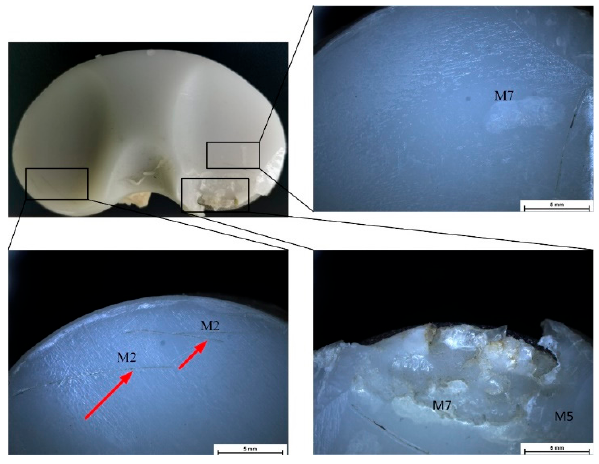
Figure 4. Stereomicroscopy images obtained in the case of IT1 sample.